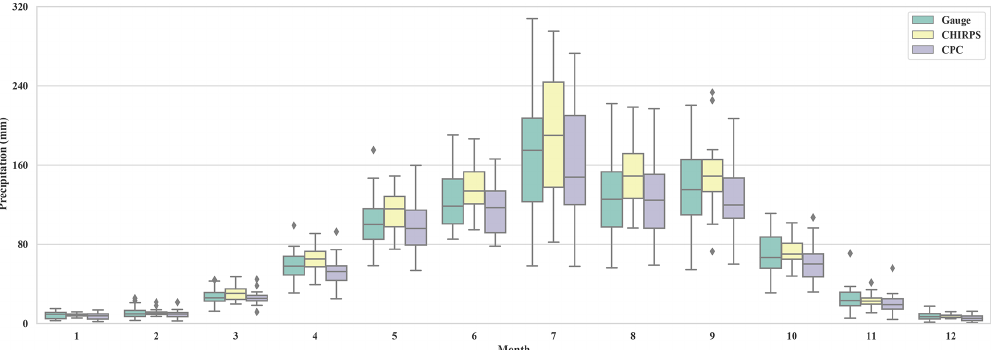
Figure 4. Box diagrams of three different precipitation records at a monthly scale in the